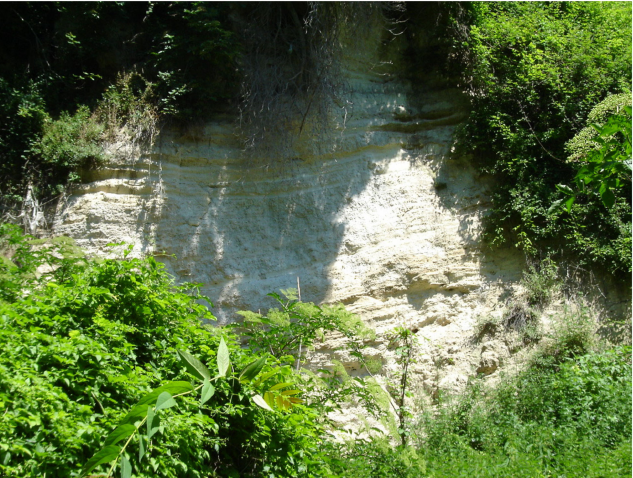
Figure 1. Stratified stromatolithic tufa in the upper basin of the Esino River (Marche, Italy).